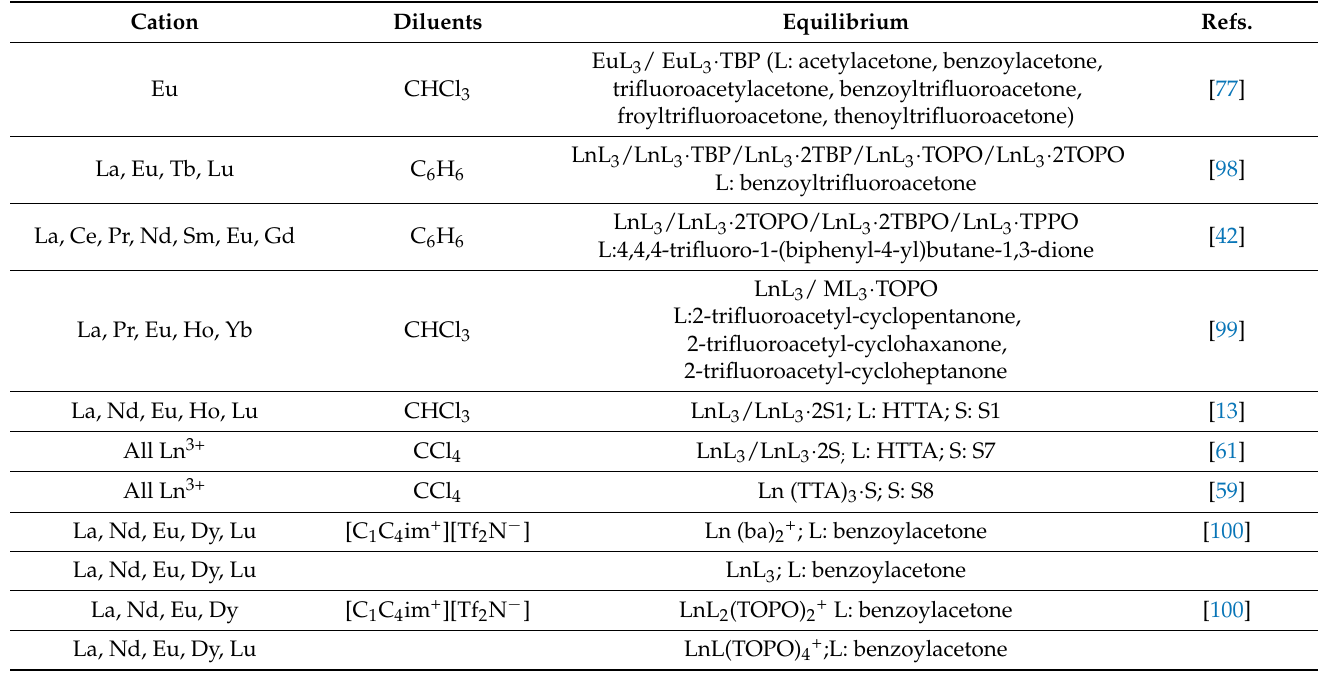
Table 6. Summary of synergistic systems containing β -diketone and organophosphorus ligands used for the solvent extraction of trivalent